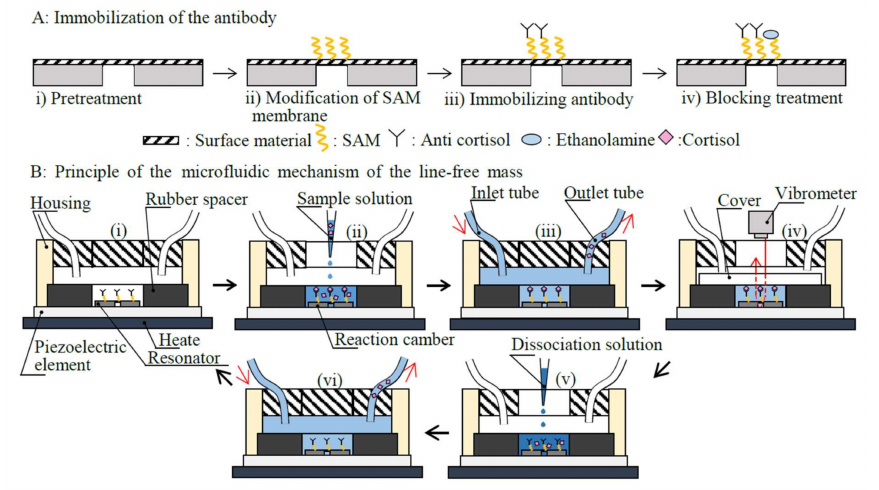
Figure 2. Schematic of immobilization of the antibody and the principle of the line-free mass sensor using the microfluidic mechanism (the schematic is not drawn to